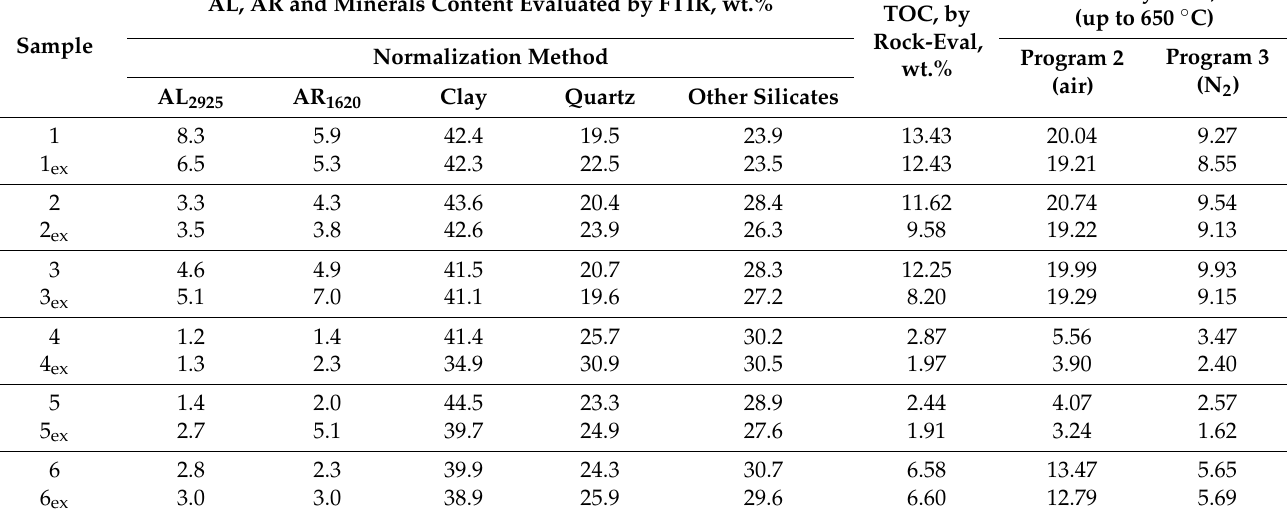
Table 4. Comparison of aliphatic and aromatic fragments content and composition measurements in rock samples (after acid treatment) by Rock-Eval pyrolysis, TGA and FTIR spectroscopy in transmission mode (0.25 wt.% sample in KBr pellet). AL, AR and Minerals Content Evaluated by FTIR, Sample